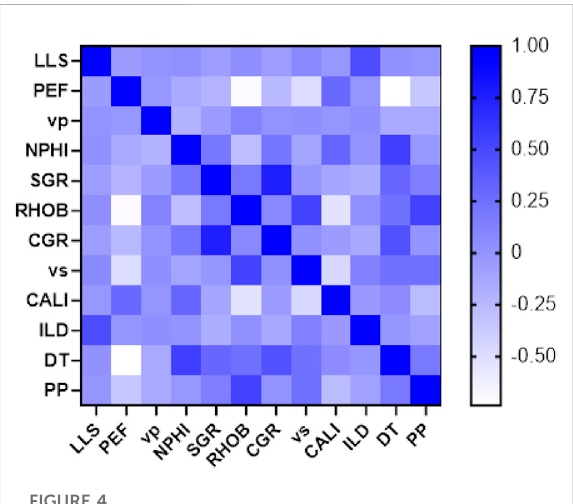
FIGURE 4 Heat map diagram for relationship between input